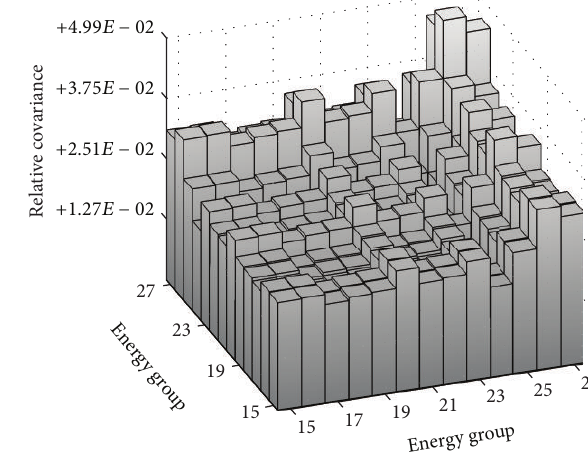
Figure 13: 𝜎 U 238 𝑒 covariance at 𝜎 0 = 52𝑏 .